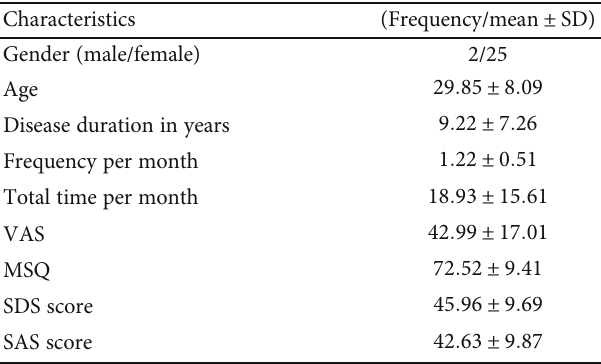
Table 1: The demographic and clinical data during the past four weeks ( n = 27